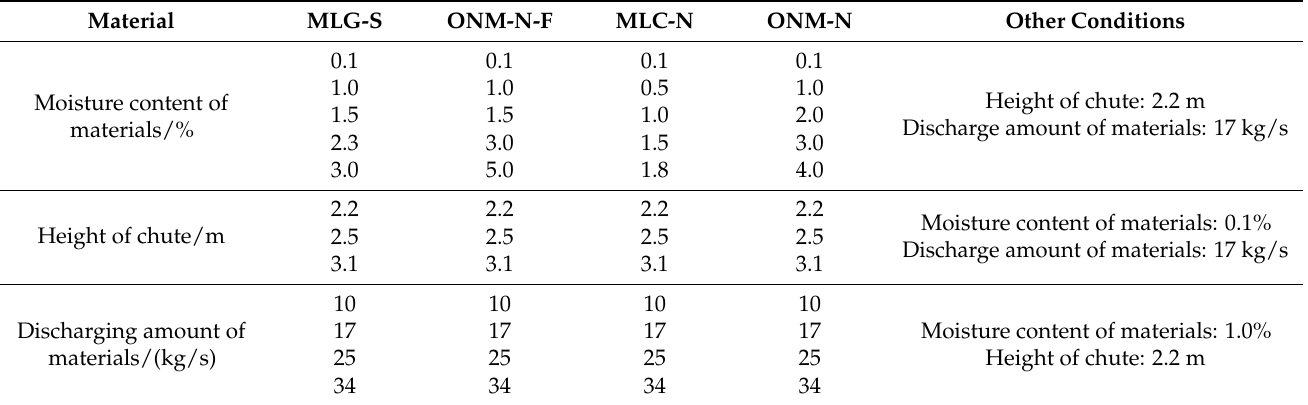
Table 2. Experimental scheme for investigating the diffusion behaviors and concentrations of dust with different